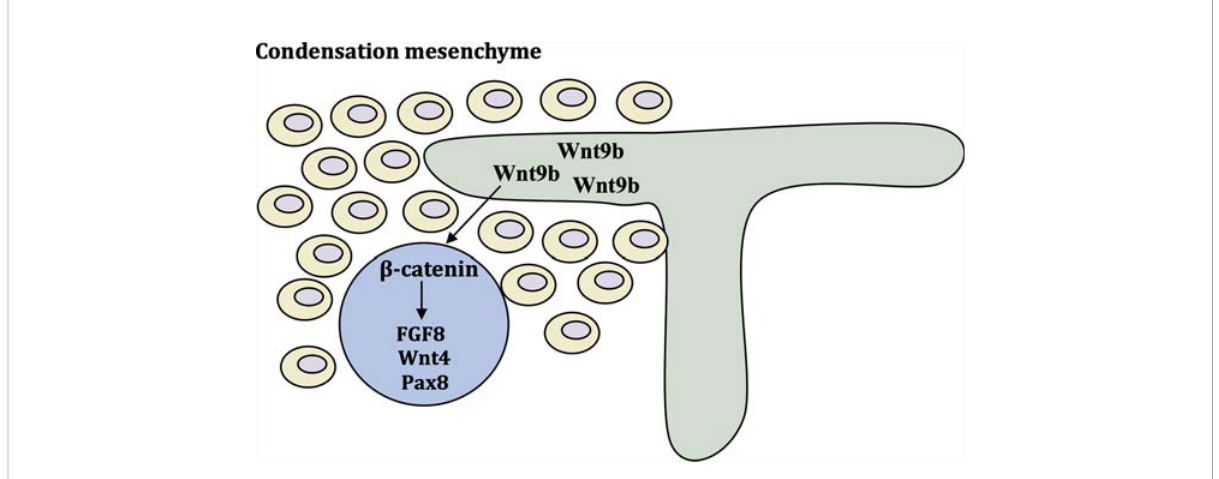
FIGURE 2 Molecular control of early kidney development. Wnt9b is expressed in ureteric bud and turns on differentiation markers FGF8, Wnt4 and Pax8 via b -catenin pathway. These cells form the pre-tubular aggregate highlighted by the expression of critical differentiation factors Pax8 FGF8 and